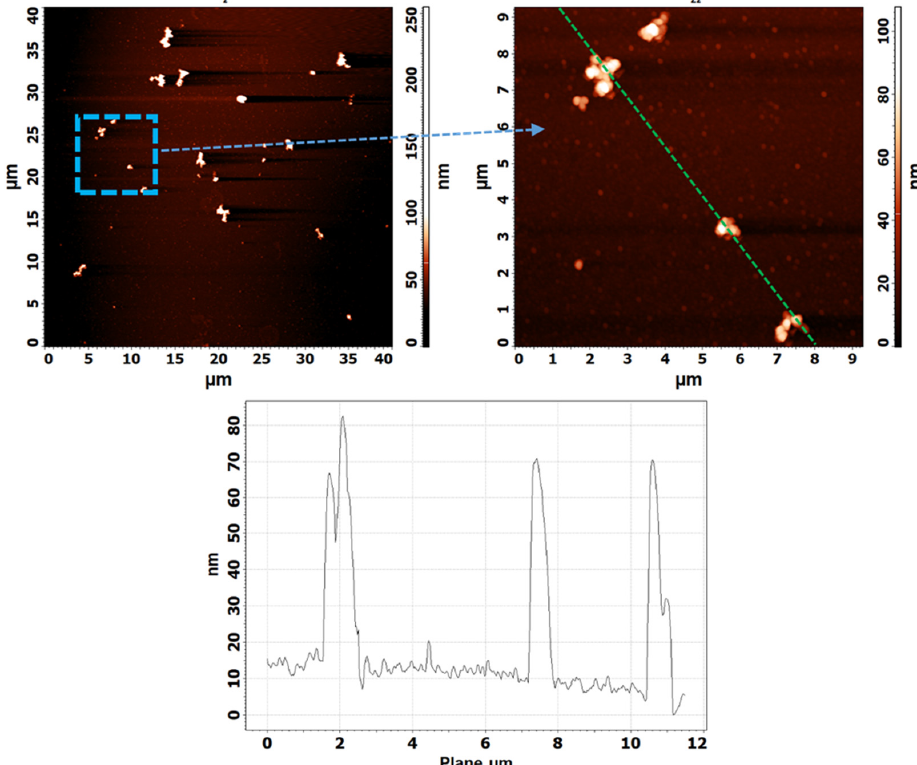
Figure 4. AFM images of the silver surface of the SERS-active substrate with a sample of the RBD of the SARS-CoV-2 S glycoprotein with reduced disulfide bonds applied onto it. The left panel shows a 40 × 40 μ m area; the right panel shows the image obtained in the area marked with a blue square in the left panel (9 × 9 μ m); the bottom panel shows the cross-section along the green line in the right panel.